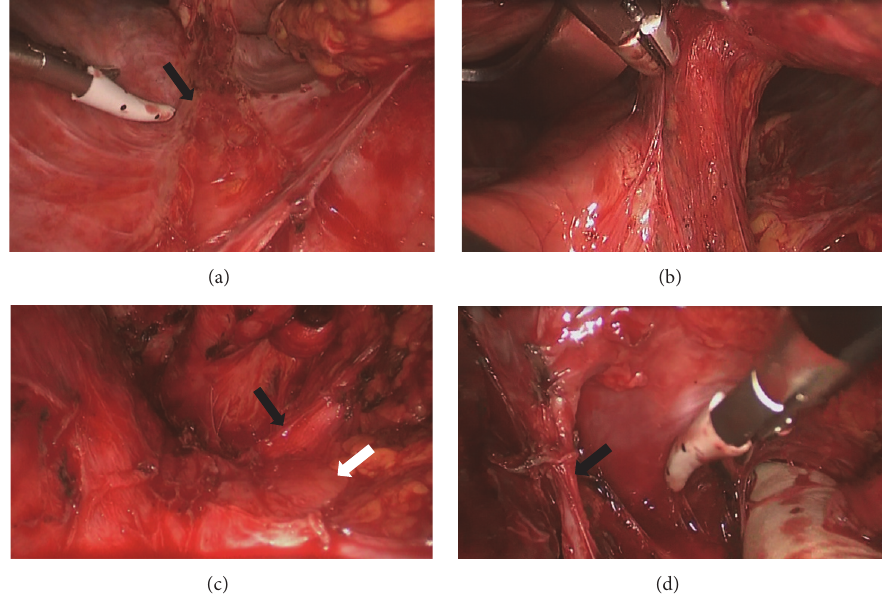
Figure 2: (a) Adhesion between thepericardium and thestaple lineof thegastrictube (black arrow). (b)Adhesion between theback surfaceof the sternum and the omentum. (c) Superior vena cava (black arrow) and left brachiocephalic vein (white arrow). (d) Right internal mammary vein (black